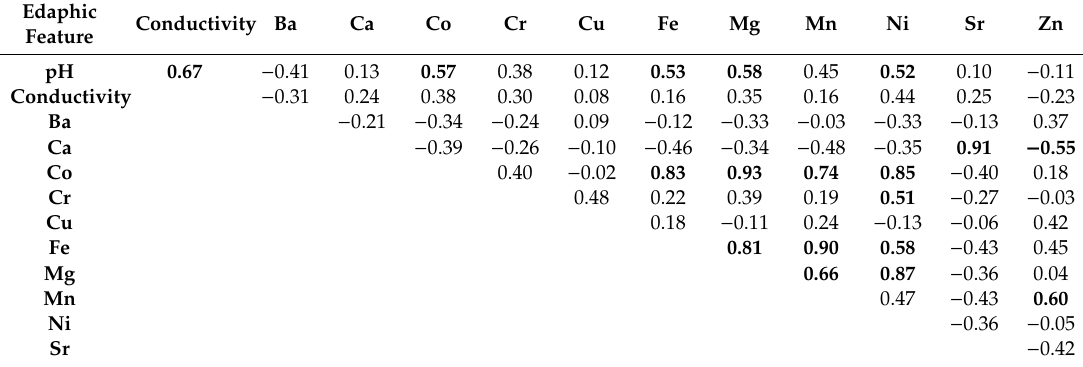
Table 5. Pearson correlation coe ffi cients between elemental concentrations in rocks, pH and conductivity of water